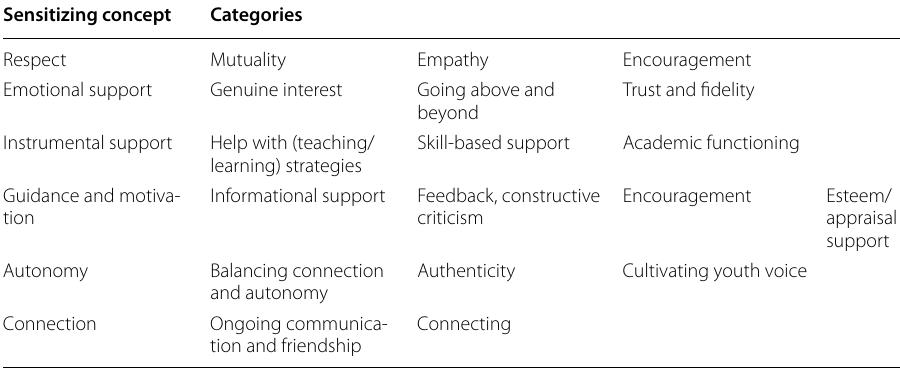
Grouped according to overlapping